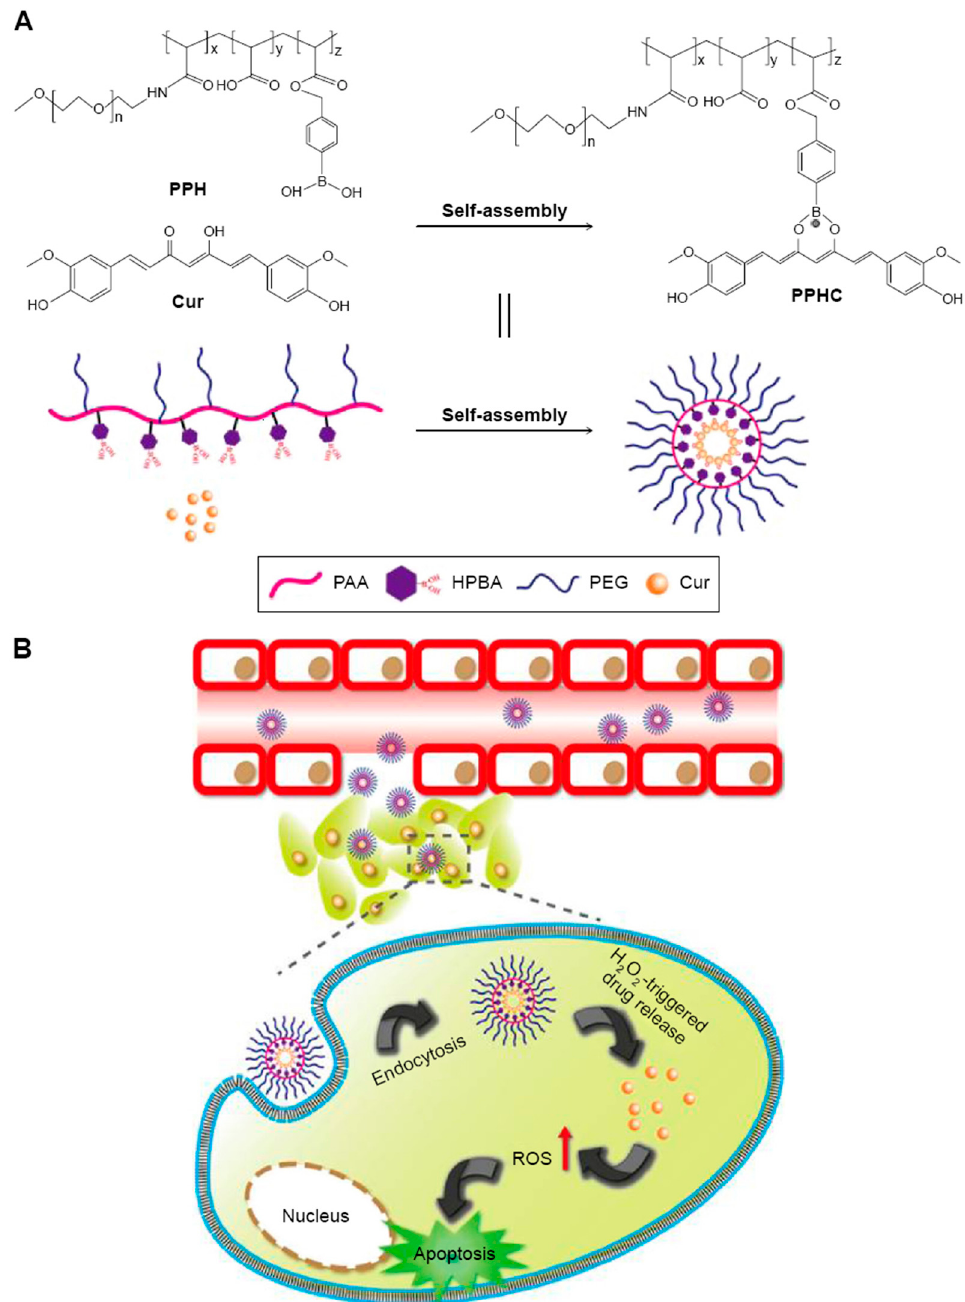
Figure 6. Schematic depiction of the preparation and intracellular delivery of reactive oxygen species (ROS)-sensitive responsive nanoparticle (PPHC) nanoparticles. ( A ) Preparation of ROS-responsive PPHC nanoparticles showing coordination between boronic acid and Cur. ( B ) Graphical representation of intracellular ROS-triggered drug delivery and cell apoptosis induced by amplified ROS signals. Abbreviations: PPH, 4-(hydroxymethyl) phenylboronic acid-modified PEG-grafted poly (acrylic acid) polymer; Cur, curcumin; PAA, poly(acrylic acid); HPBA, 4-(hydroxymethyl) phenylboronic acid; PEG, poly(ethylene glycol). Reprinted with permission from International Journal of Nanomedicine , 12 , 855. Copyright 2017 Dove Press [103].